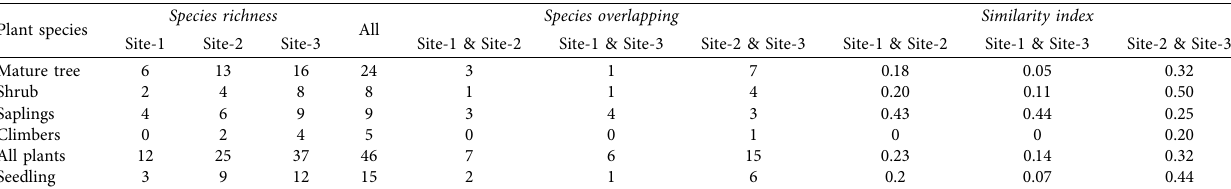
Table 6: Species richness, overlapping, and similarity index of plant species for three sites in study area. Plant